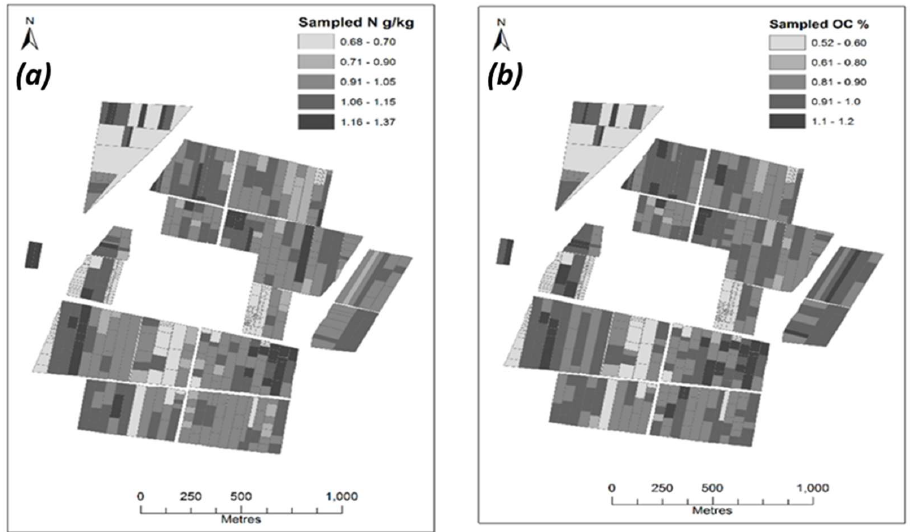
Figure 6. Measured values of ( a ) soil nitrogen content (g / kg) and ( b ) soil organic carbon (%) at the field scale.